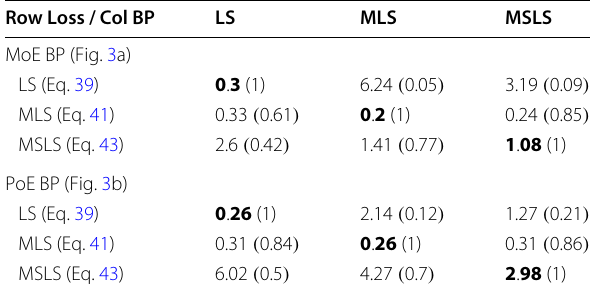
Table 4 Beampattern (BP) fitting errors for MoE and PoE targets (similarity scores in parentheses) Row Loss / Col